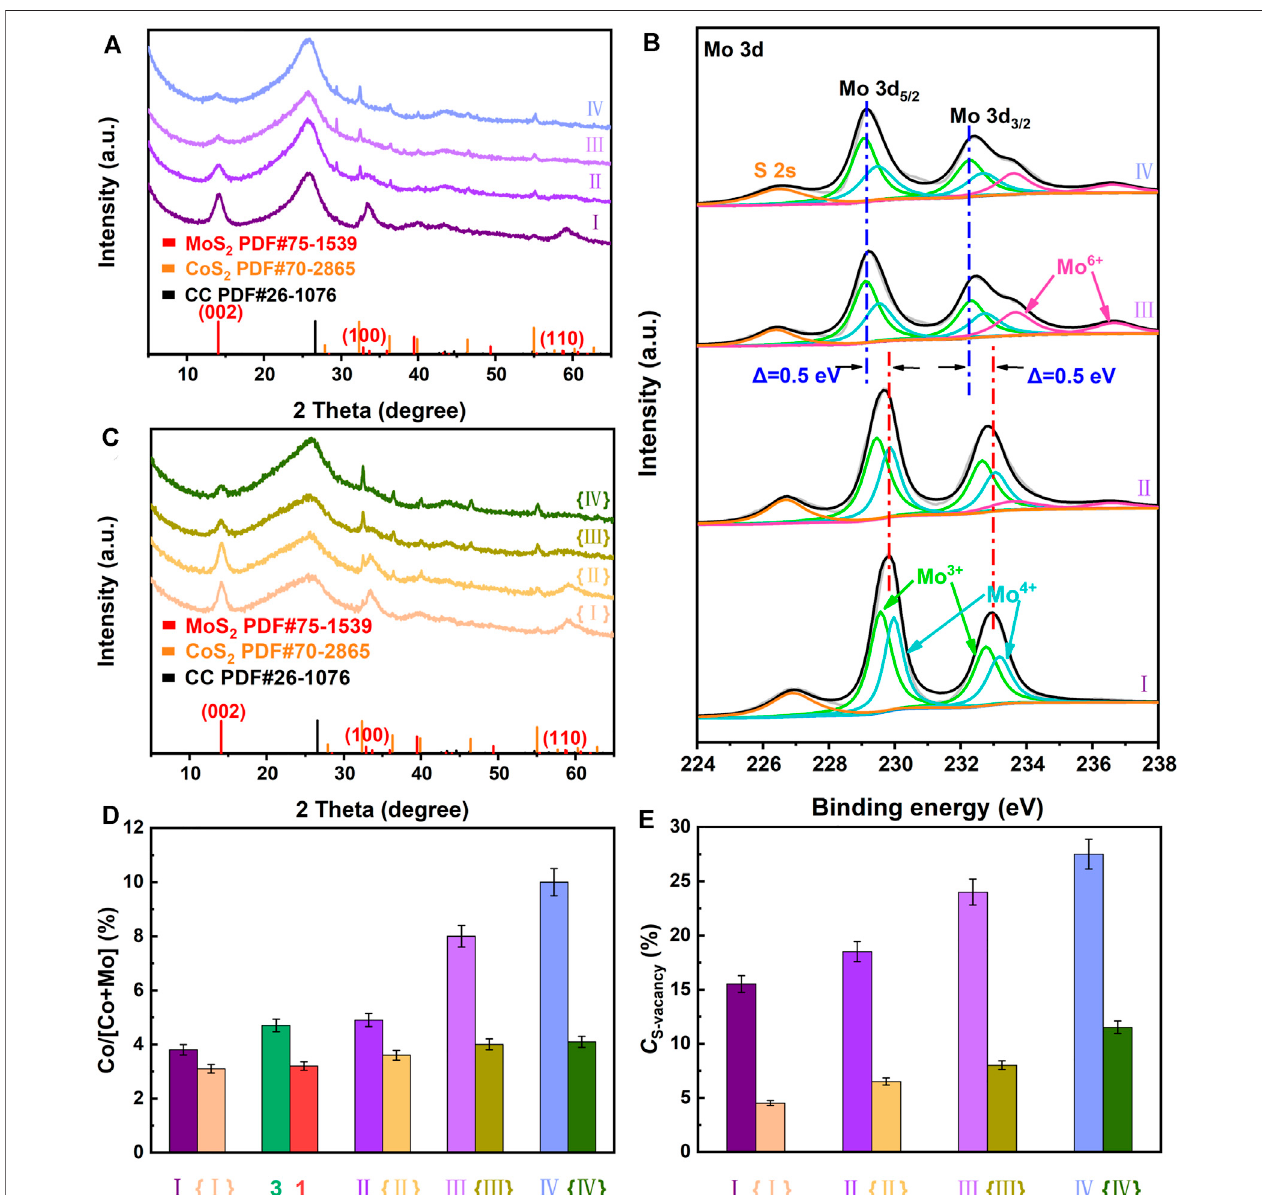
FIGURE 6 | (A) XRD patterns and (B) Mo3d high-resolution XPS spectra of Ru-MoS 2-x -CoS 2 /CC-80 ( Ⅰ ), Ru-MoS 2-x -CoS 2 /CC-240 ( Ⅱ ), Ru-MoS 2-x -CoS 2 /CC-280 ( Ⅲ ), and Ru-MoS 2-x -CoS 2 /CC-320 ( Ⅳ ); (C) XRD patterns of MoS 2 -CoS 2 /CC-80 ({ Ⅰ }), MoS 2 -CoS 2 /CC-240 ({ Ⅱ }), MoS 2 -CoS 2 /CC-280 ({ Ⅲ }), and MoS 2 -CoS 2 /CC-320 ({ Ⅳ }); (D) atomratios ofCoto(Co+Mo)byXPSdata, (E) C S-vacancy oftherelated samples.Meanwhile,fabricationsofMoS 2 -CoS 2 /CC-80,MoS 2 -CoS 2 /CC-240, MoS 2 - CoS 2 /CC-280, and MoS 2 -CoS 2 /CC-320 are almost the same as those of Ru-MoS 2-x -CoS 2 /CC-80, Ru-MoS 2-x -CoS 2 /CC-240, Ru-MoS 2-x -CoS 2 /CC-280, and Ru-MoS 2-x -CoS 2 /CC-320 except for the absence of RuCl 3